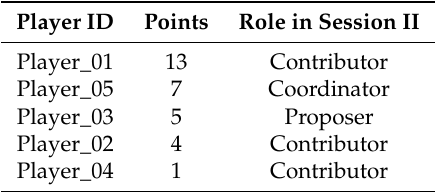
Table 3. Example of leaderboard after the second innovation